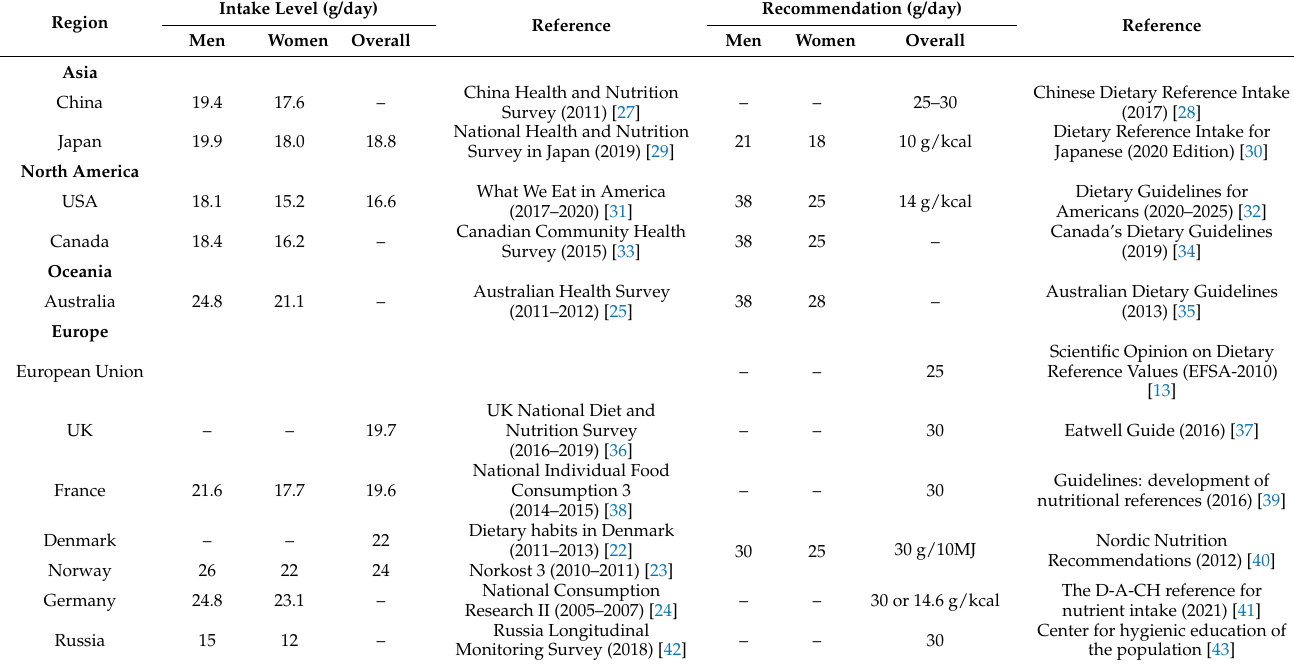
Table 1. Global intake and recommendations of dietary